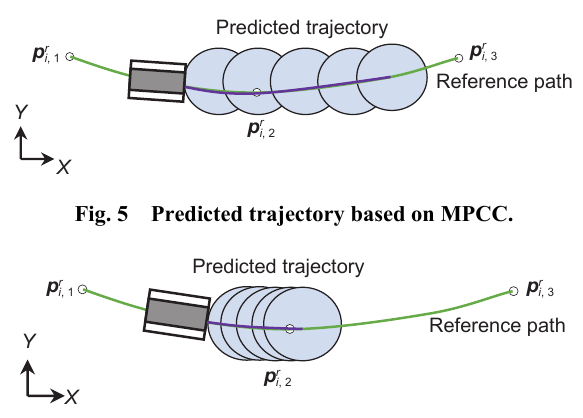
Fig. 6 Predicted trajectory if no feasible solution is detected (we let v = 0). ref